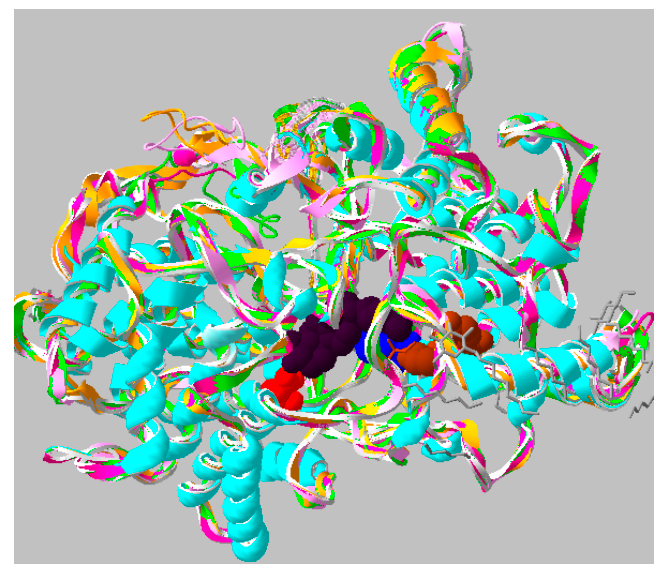
Figure 4. Homology models of fruit OSCs superimposed on the human crystal structure (1w6k). Cyan, human; yellow, orange and pink, XP_021819911.1, XP_021819927.1 and XP_021819928.1; green, MdOSC1. The product, along with important residues, are shown only for human OSC. Black, lanosterol; blue, H232; brown, substrate entry point (C233, Y237, I524); red, active site D455 involved in protonation of oxidosqualene substrate. Grey, β -octylglucoside showing enzyme regions interacting with hydrophobic membrane-inserting surface.